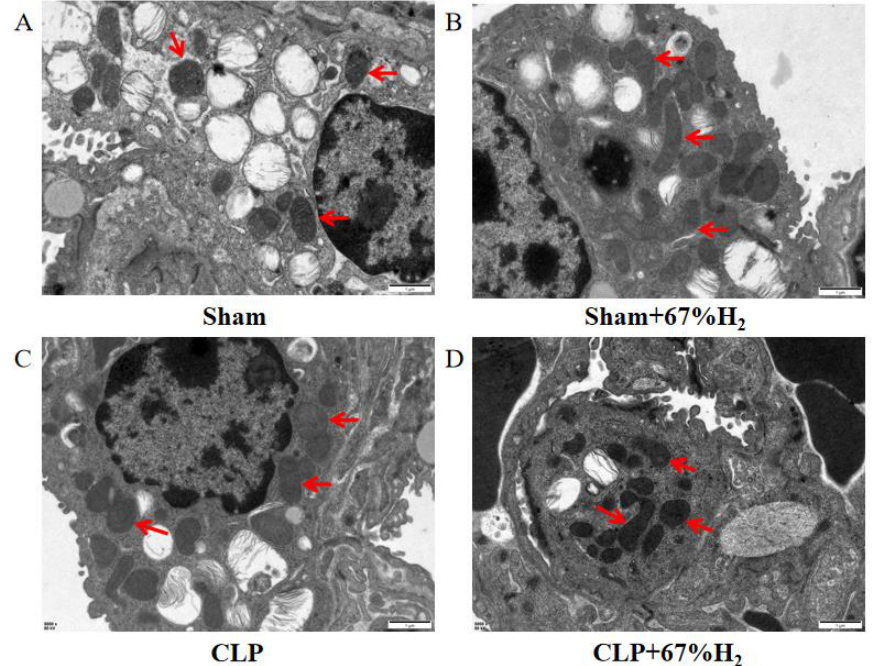
Figure 4. A total of 67% H 2 inhalation reduced the degree of mitochondrial damage. As shown by the red arrows, ( A , B ) Mitochondrial ridges were intact without swelling. ( C ) Mitochondria became vacuolated and no mitochondrial ridges were observed. ( D ) Part of the mitochondrial ridges disappeared and the mitochondria were slightly swollen.